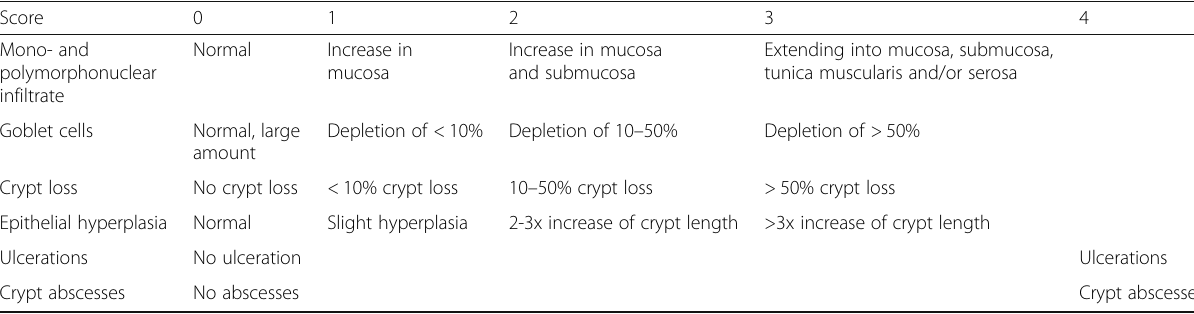
Table 3 Histology score adapted from Read et al.